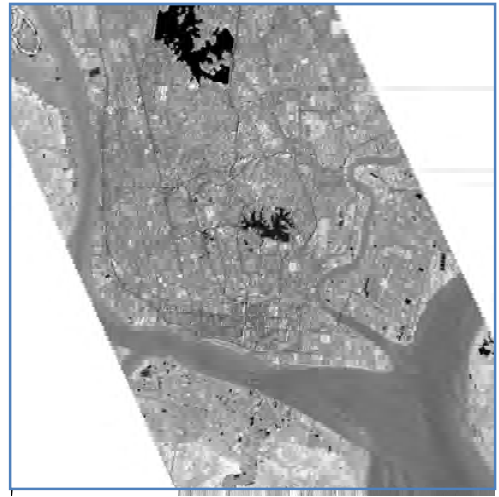
Figure 8. SRTM data of Yangon river